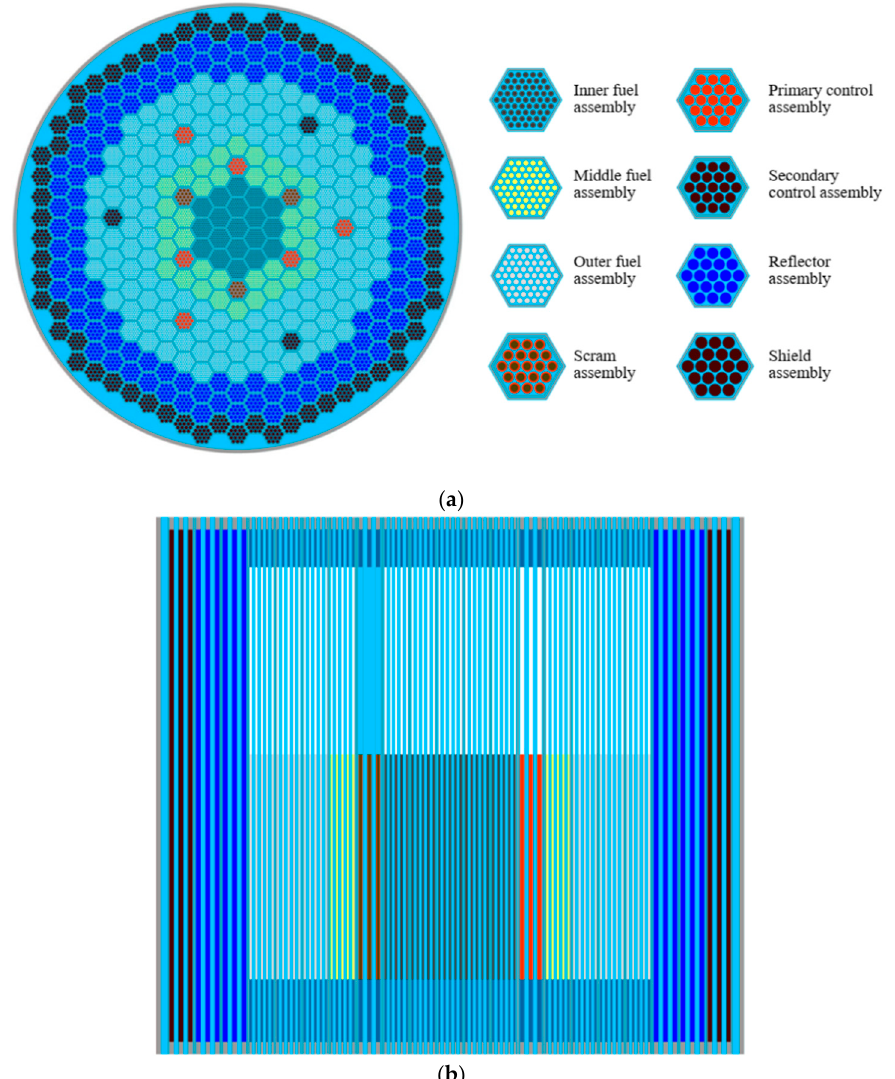
Figure 1. Detailed radial and axial configuration of the core. ( a ) Radial configuration of the core, and ( b ) axial configuration of the core.